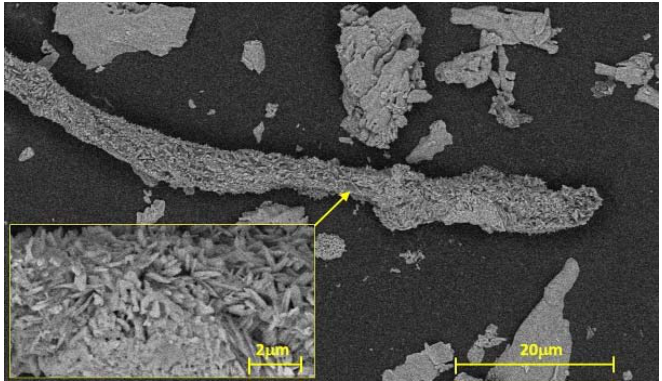
Figure 1. The SEM micrograph of the nano ‐ cellulose.